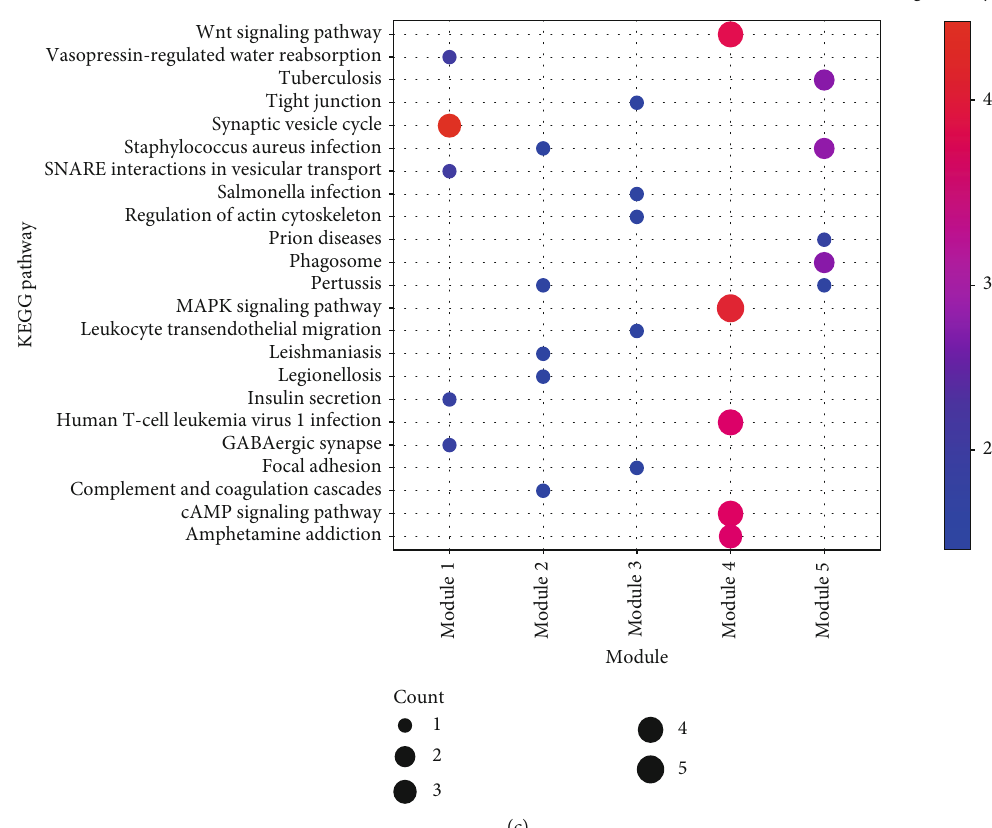
Figure 3: Protein-protein interaction (PPI) network constructed by cluster genes in three clusters, fi ve modules, and KEGG pathway analysis for module genes. (a) The PPI network and (b) fi ve modules. Red nodes represent cluster 1 genes, blue nodes represent cluster 2 genes, and green nodes represent cluster 3 genes. Circle nodes represent upregulated genes, and rhombus nodes represent downregulated genes. Node size represents the degree of connectivity. (c) KEGG pathway analysis for module genes. Bubble size indicates the number of enriched genes. The redder the bubble color, the more signi fi cant this